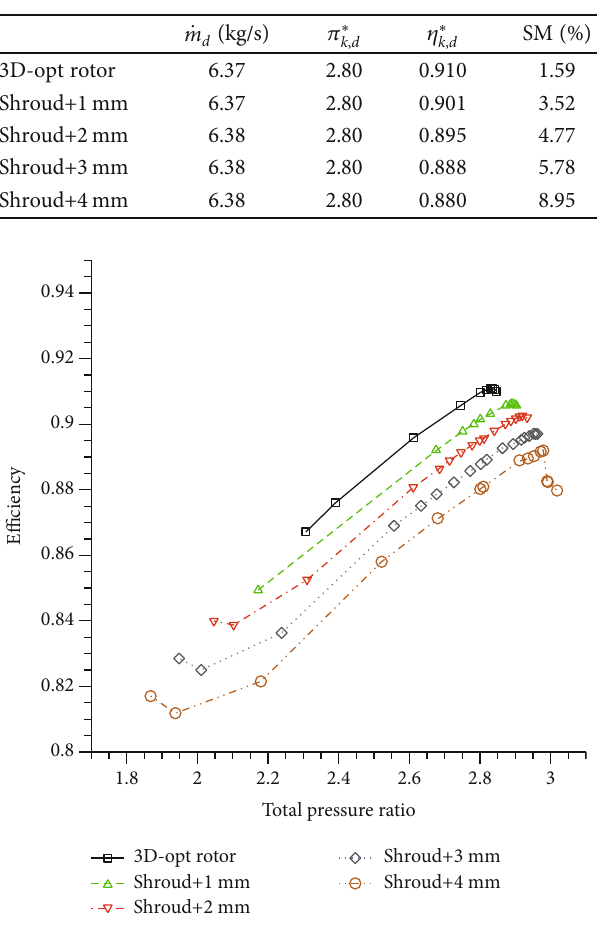
Figure 14: Relationship between total pressure ratio and e ffi ciency for the fi ve